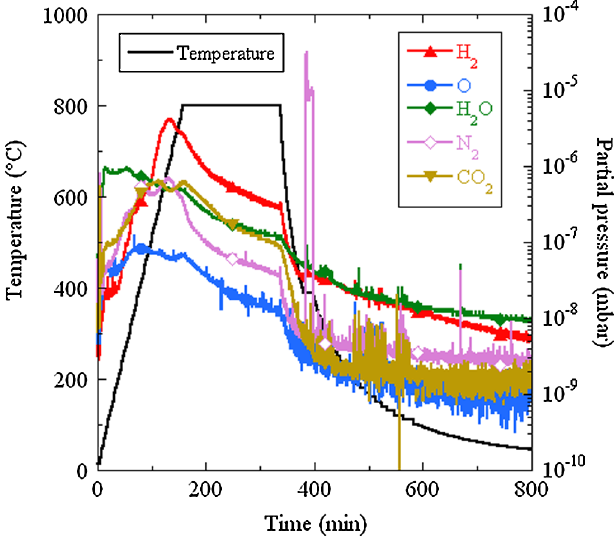
FIG. 12. (Color) Partial pressure of the residual gases and tem- perature profile during the cavity heat treatment. Nitrogen was injected into the furnace at 400 (cid:1) C for 15